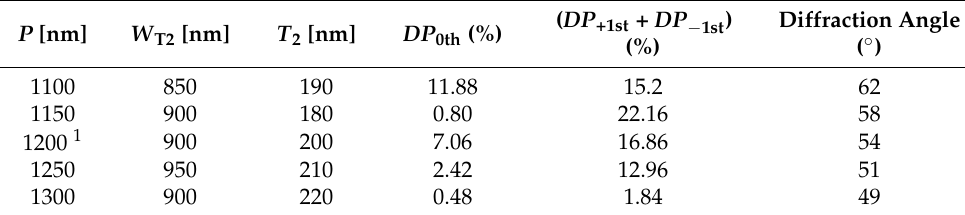
Table 1. In the case of backward illumination, detailed diffraction results within the periodic condition range satisfying the provision of asymmetric